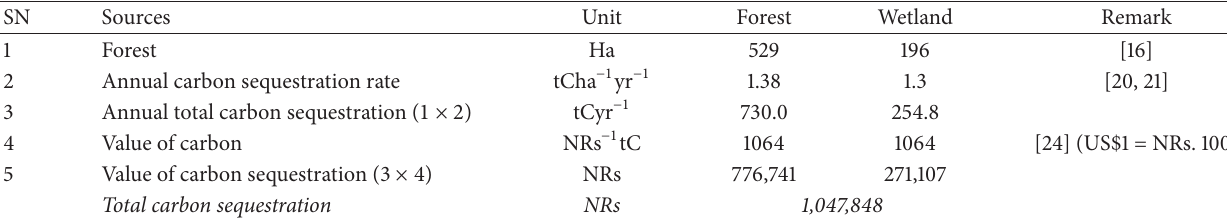
Table 9: Value of carbon sequestration.